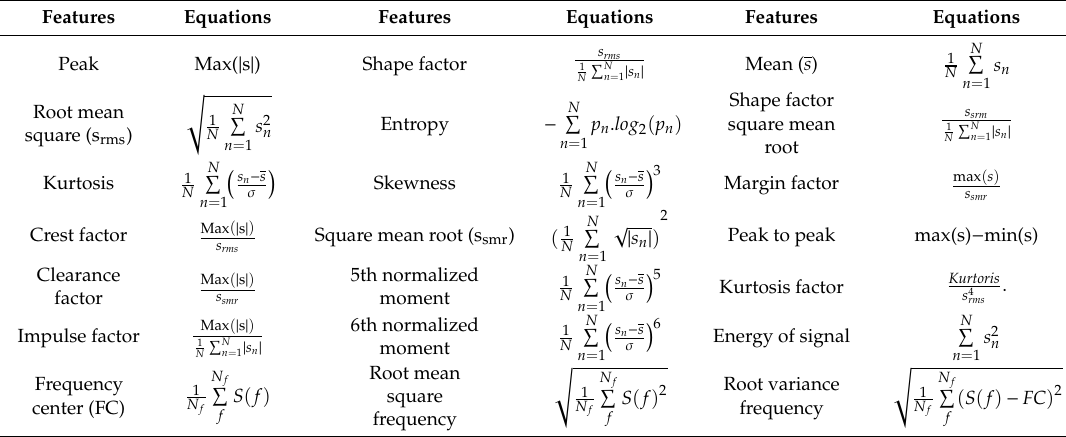
Table 3. Definition of statistical features in the time and frequency